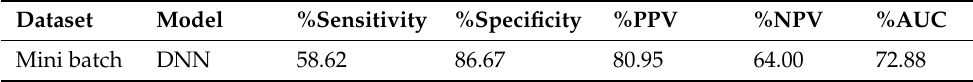
Table 6. Perfomance of the DNN’s tests on the mini batch dataset.